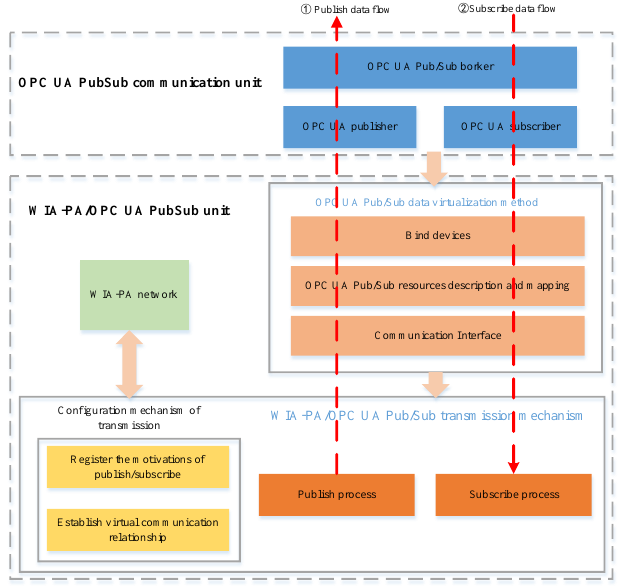
Figure 4. System architecture of WIA-PA/OPC UA joint pub/sub scheme.